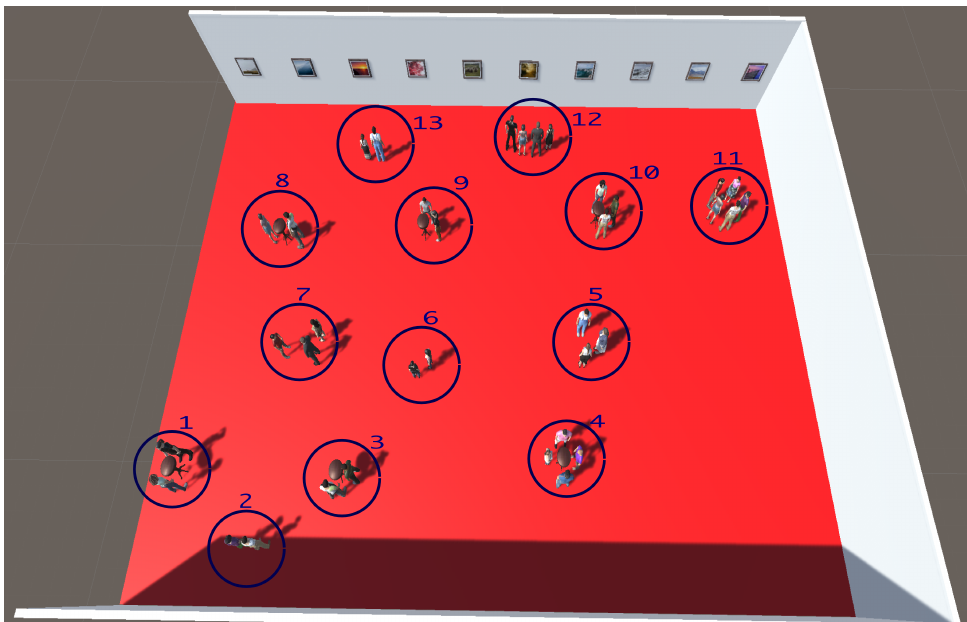
Figure 18. Scene 2 consists of a number and variety of F-formations. The 13 formations are numbered and listed as follows: 1 and 8 are vis-a-vis formations; 2 and 13 are side-by-side formations; 3, 6, and 9 are L-shape formations; 4, 5, 10, and 11 are circular formations; 12 is semi-circular formation; 7 is triangular formation.